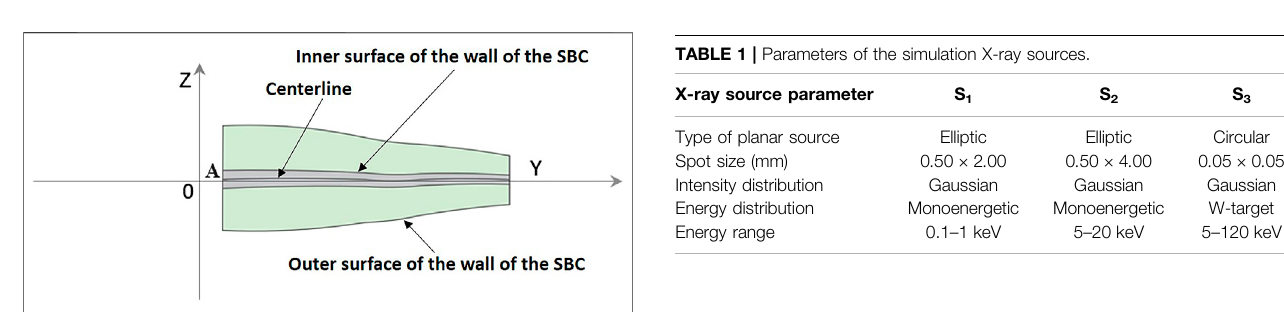
FIGURE 6 | Schematic diagram of the SBC with centerline and surface shape errors.